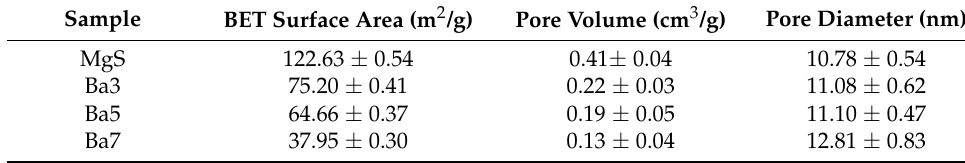
Table 2. Surface area parameters for the MgS cement before and after BaO doping.